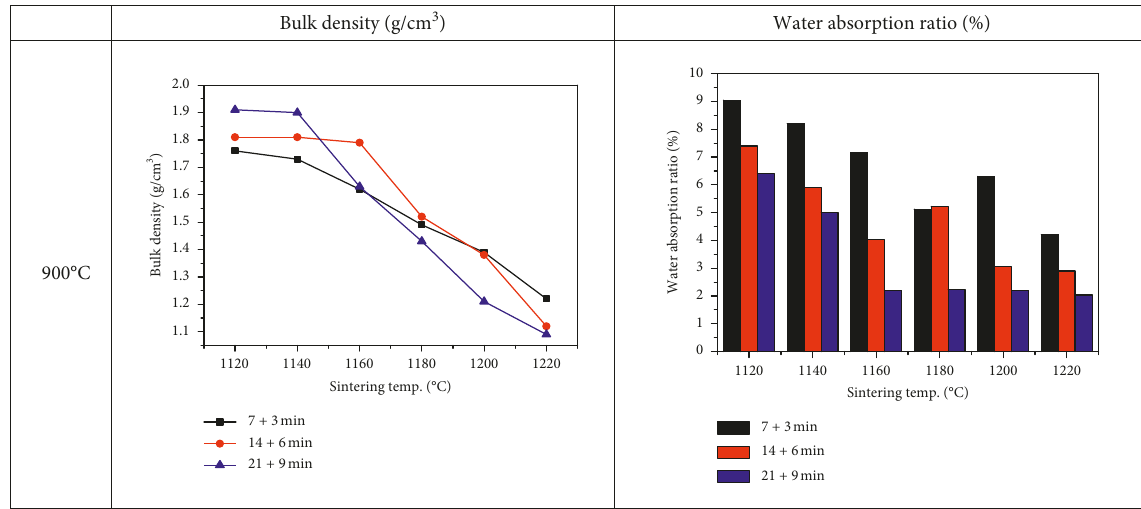
Figure 7: Physical properties of the lightweight aggregate by 2-step firing with a variation in input temperature. Bulk density and water absorption